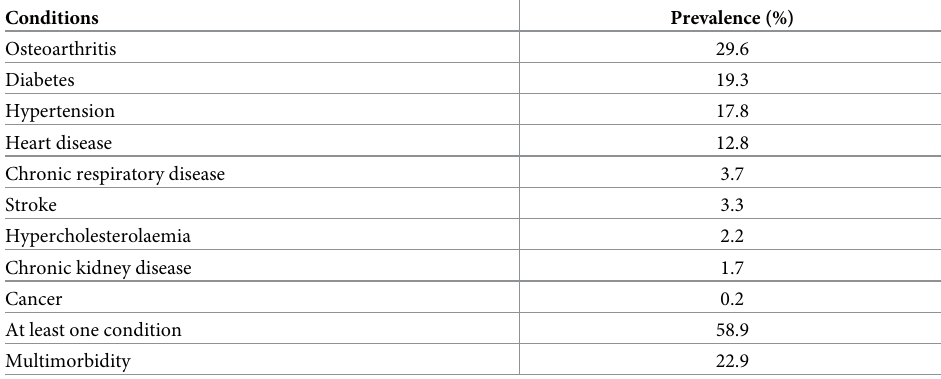
Table 3. Prevalence of single conditions and multimorbidity (n =